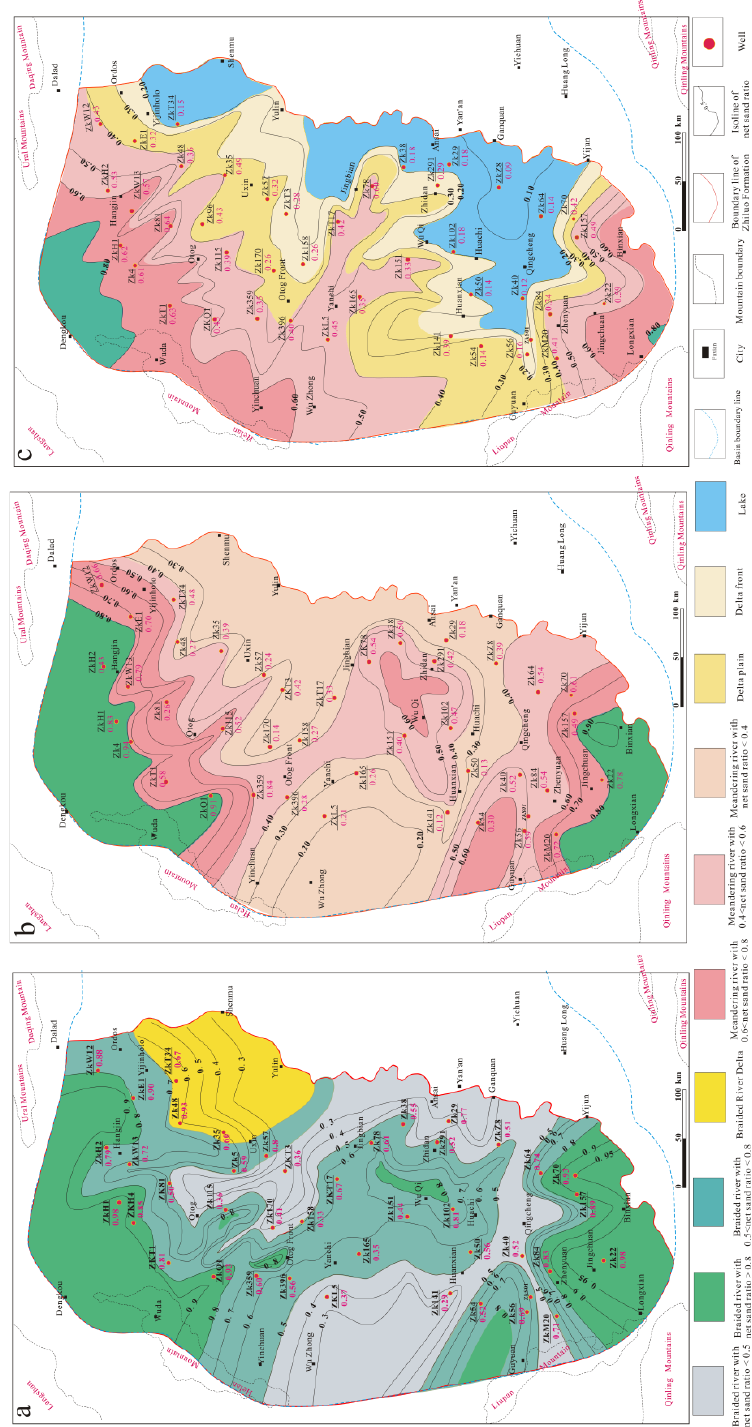
Figure 7. Lithofacies paleogeographic map of the Jurassic Zhiluo Formation. ( a ) Lithofacies paleogeographic map of the J 2 z 1-1 ; ( b ) Lithofacies paleogeographic map of the J 2 z 1-2 ; ( c ) Lithofacies paleogeographic map of the J 2 z 2